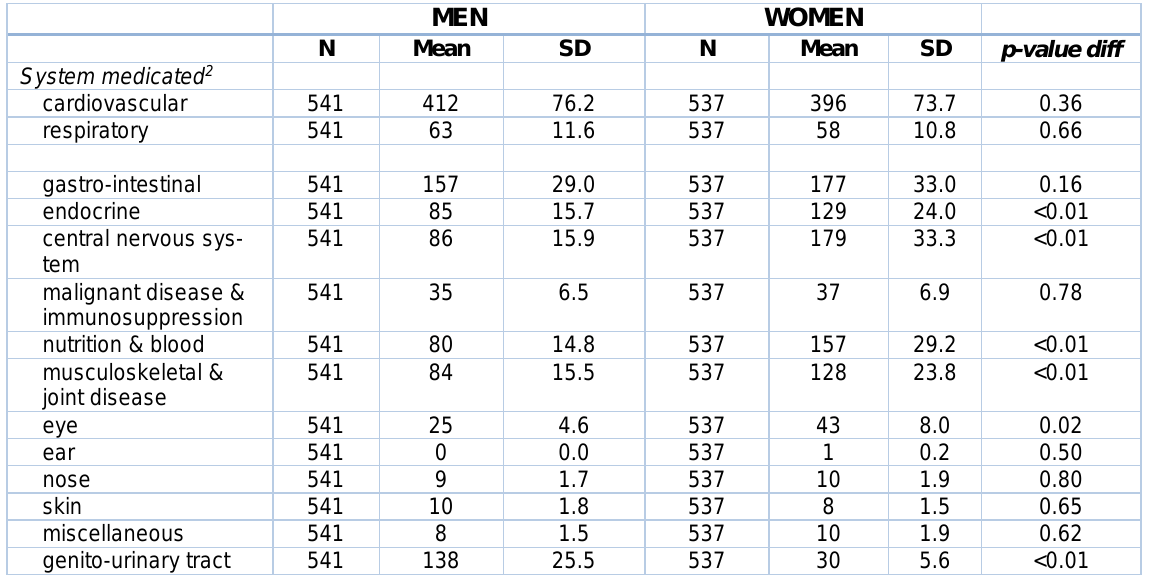
Table 1 (cont.): Participants’